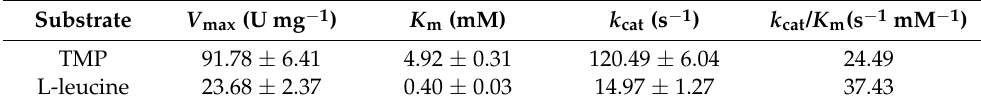
Table 2. Kinetic parameters of Pb LeuDH for TMP and